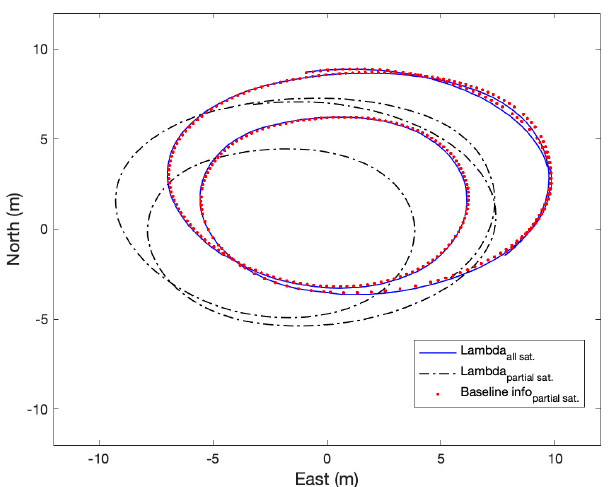
Figure 16. Comparison of the trajectory of a follower receiver using LAMBDA with all satellites in view, LAMBDA with partial satellites in view, and the proposed method with partial satellites in view. The LAMBDA solutions were obtained using RTKLIB. The test data were taken at the fourth industry revolution test site of Hongik University, Korea, on 12 September 2019.